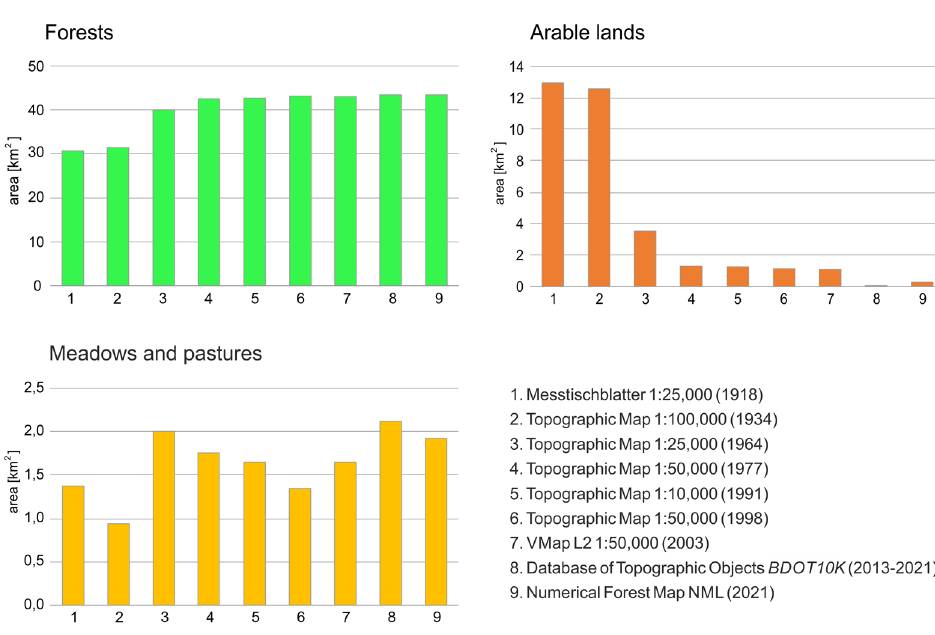
Fig. 8. Area of the analysed land use types based on cartographic